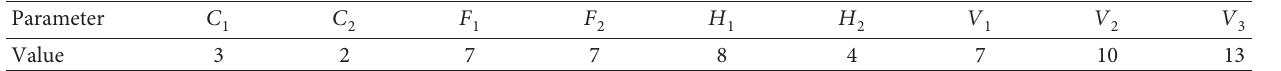
Table 5: The initial values of parameters.